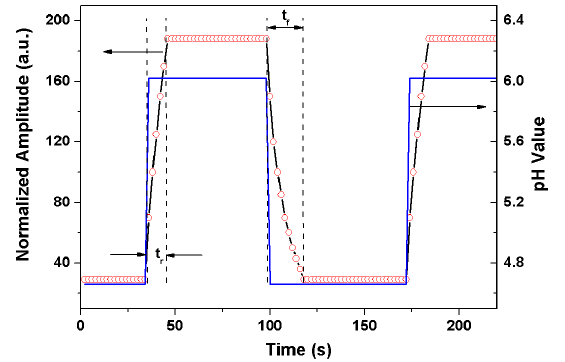
Figure 9. The measured dynamic response of the TFBG pH sensor with (PDDA/PAA)